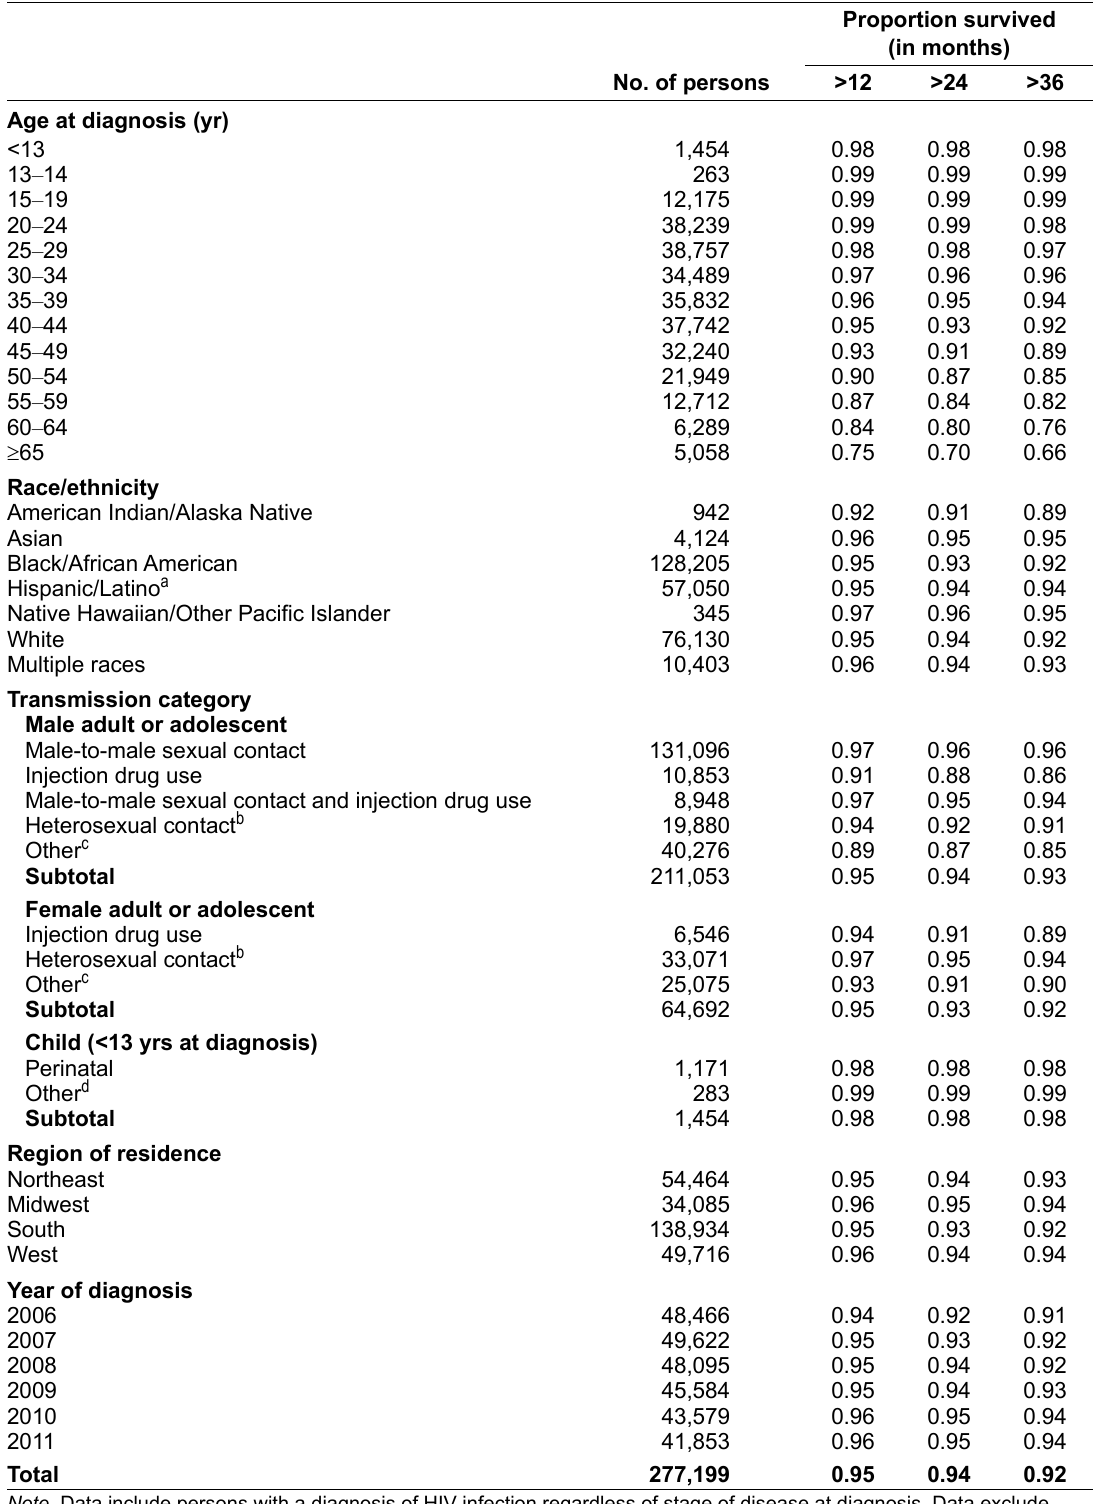
Table 16a. Survival for more than 12, 24, and 36 months after a diagnosis of HIV infection during 2006–2011, by selected characteristics—United